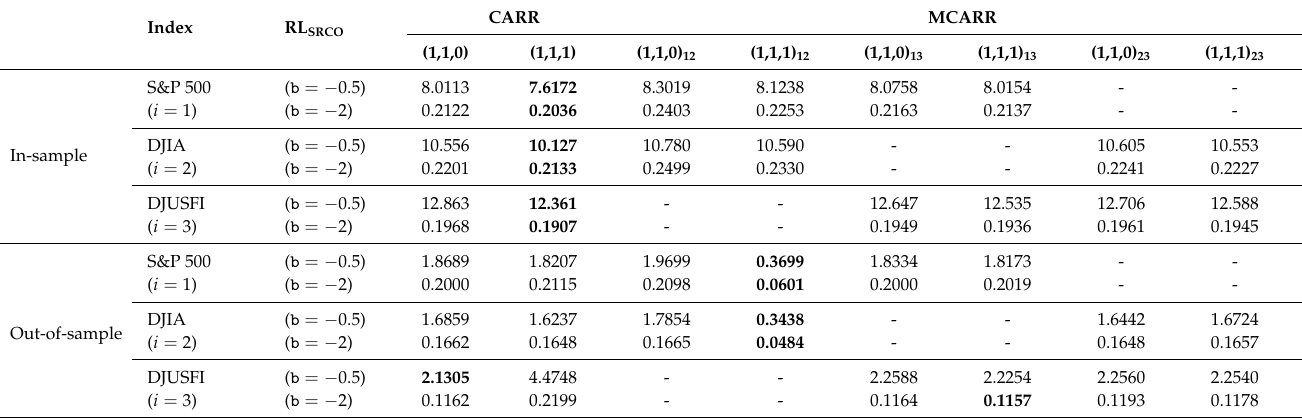
Table 3. Robust loss functions at two asymmetric levels (b = − 0.5, − 2) for in-sample estimates and out-of-sample volatility forecasts using CARR (univariate) and MCARR (multivariate) models fitted to SRPK measures for S&P 500, DJIA and DJUSFI indices and compared to SRCO measure as the volatility proxy. The best model with the lowest average RL in each row is highlighted in